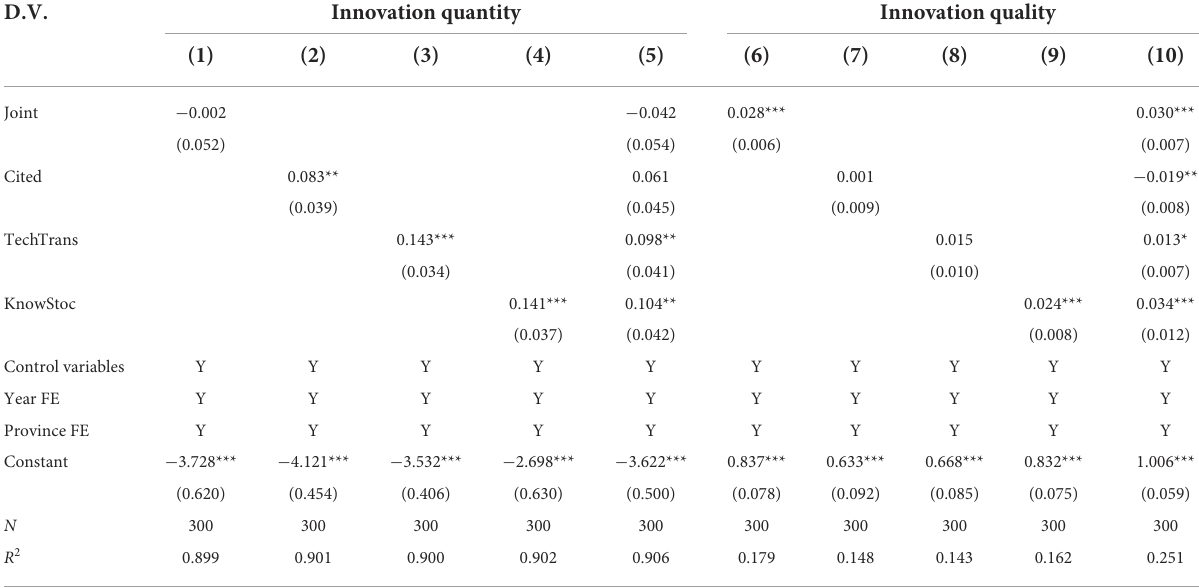
TABLE 2 The heterogeneous impact of knowledge spillover channels in universities on the quantity and the quality of green innovation.